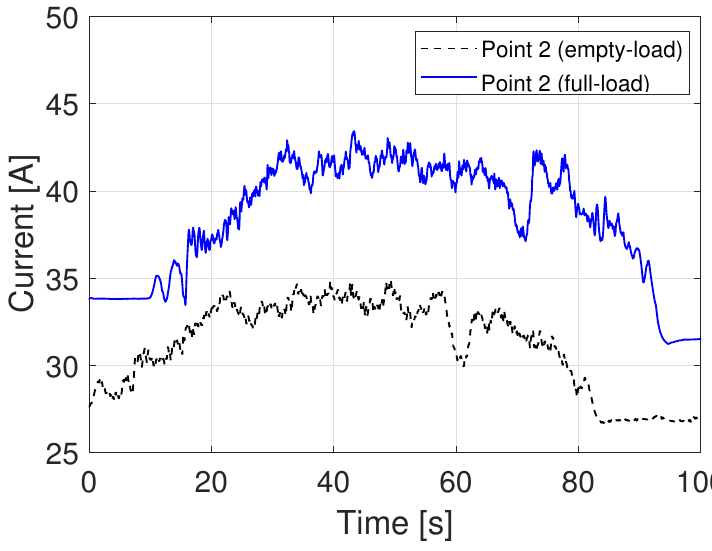
Figure 8. Experimental data of current value (the point 2 of the suspension module